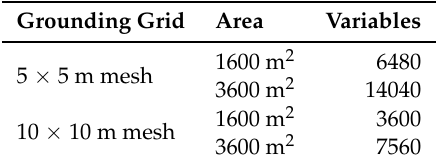
Table 1. Required number of logged variables for grounding grid of two different square mesh sizes and total area